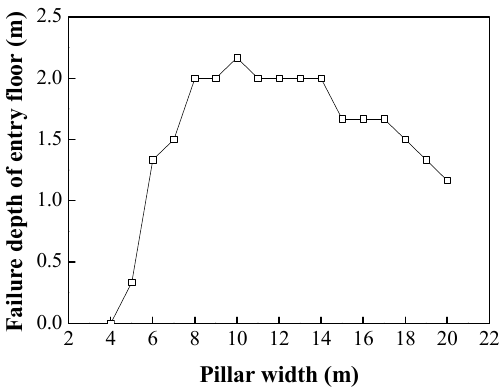
Figure 7. The relationship between the continuous failure depth of the roadway floor and the coal pillar width.